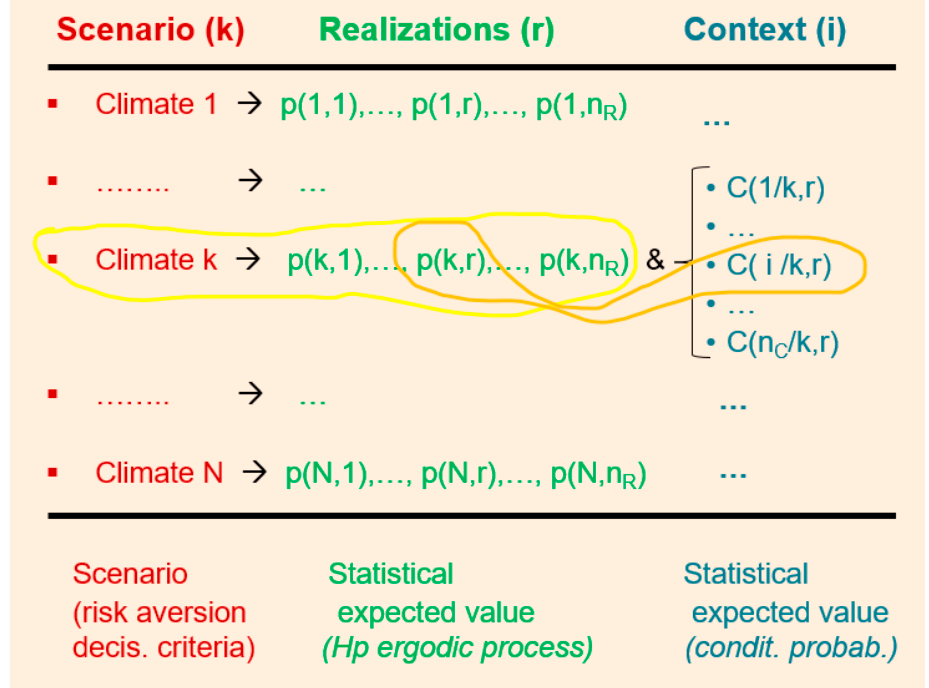
Figure 12. Representation of the uncertainty components. Given a climatic scenario, a set of n R long-term realizations (e.g., Y years) of corresponding climatic variables can be built (p, standing for spatio-temporal precipitation field, is indeed a vector of variables including temperature, wind speed, etc.); this is indicated by the light-yellow irregular oval for the generic climate k. Collaterally, any of n C context cases can occur (e.g., a levee breach in a given site) with a probability possibly dependent on the particular realization r of the k th scenario. The generic combination of events “realization r and context i” (out of the n C possible) is identified by the irregular, dark yellow loop.